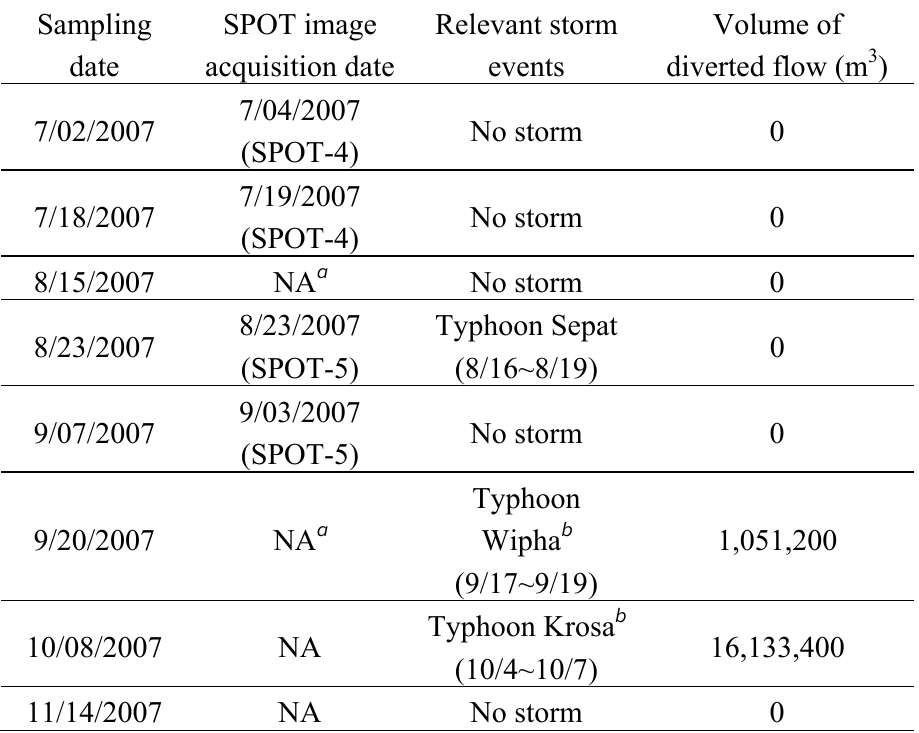
Table 1. Dates of water sampling and SPOT image acquisition.